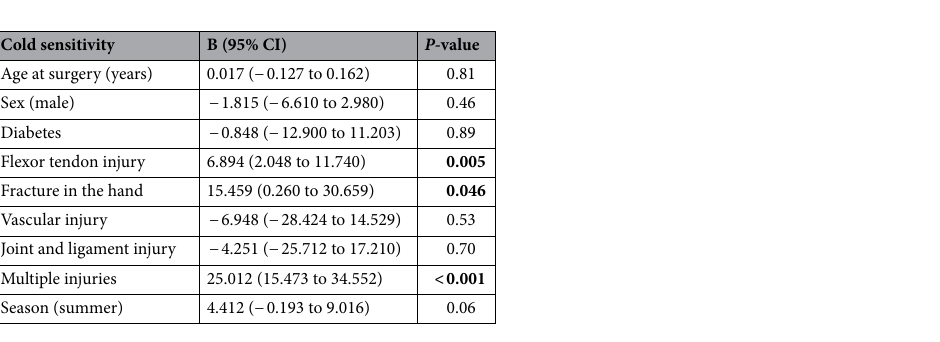
Table 4. Predicting factors for development of cold sensitivity. Data are presented as B-values (95% confidence intervals). Multiple linear regression with cold sensitivity at 12 months postoperatively as dependent variable. Bold values indicate p -value <